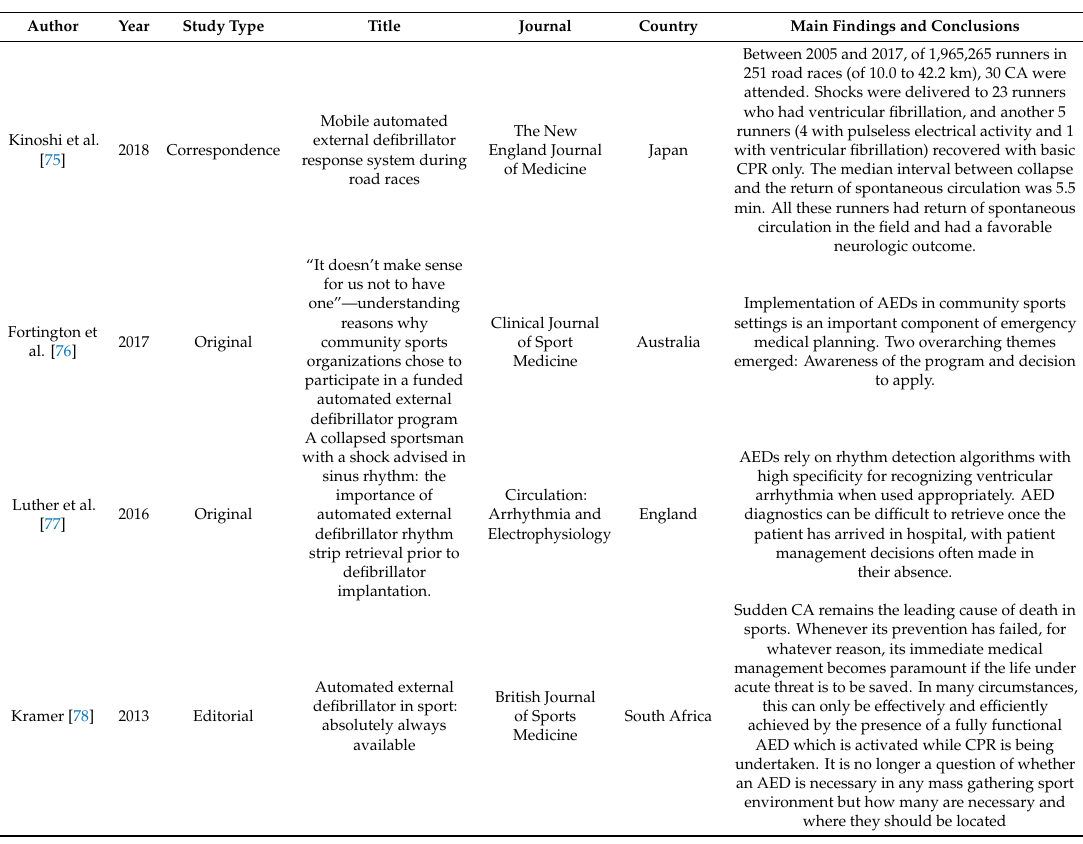
Table 7. Studies and their main conclusions related to automated external defibrillator in the context of sport and physical